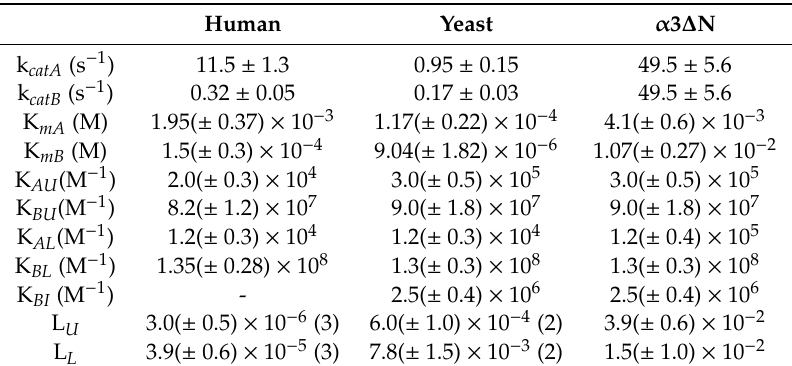
Table 1. Parameters for the description according to Equations (1)–(3) of the Tris-T4-linked e ff ect on the 20S chymotryptic-like catalytic